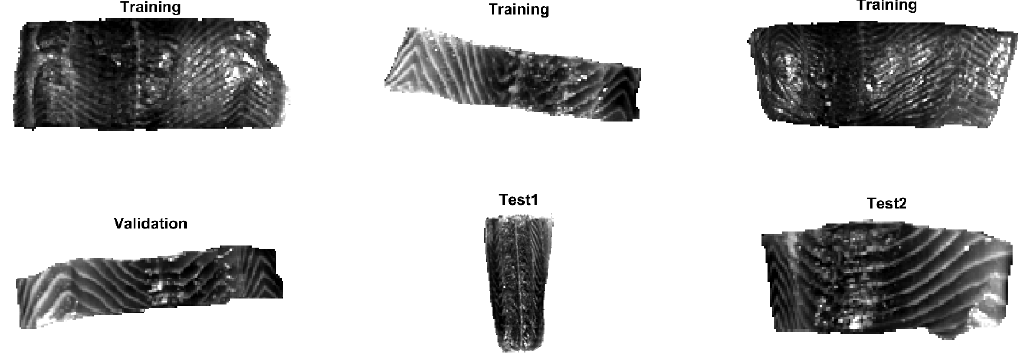
Figure 2. Mean images of salmon fillets at the spectral